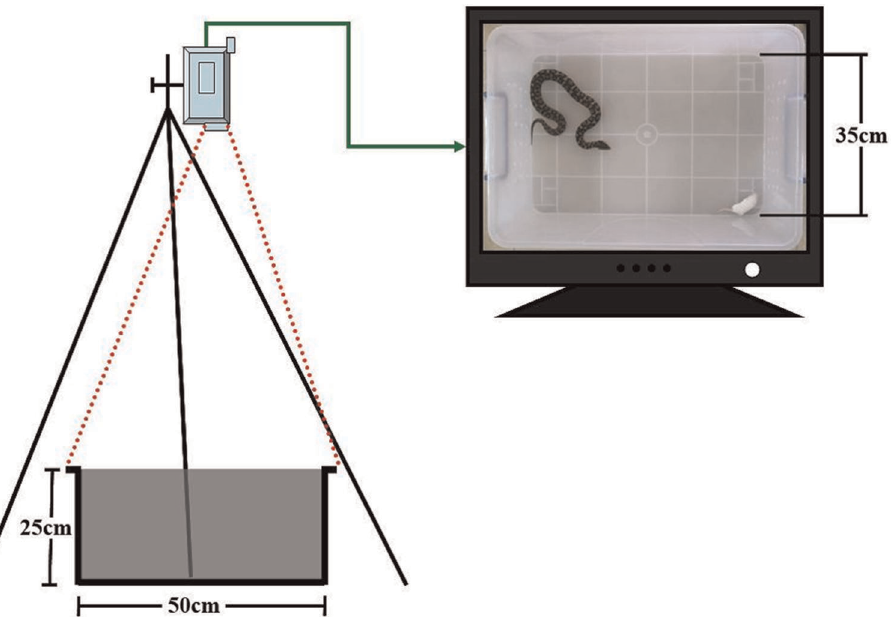
Figure 5. Demonstration of experiment and recording. A schematic diagram illustrating the experimental set-up used to measure behavior during targeting trials. A camcorder mounted on a tripod and connected to a PC was used to record the behavior of the snakes. A grid superimposed on the image was used to quantify strike distances and angles. At the beginning of each trial a mouse of appropriate size was placed directly in front of the head of the snake at the edge of the arena (see Materials and Methods for explanation).